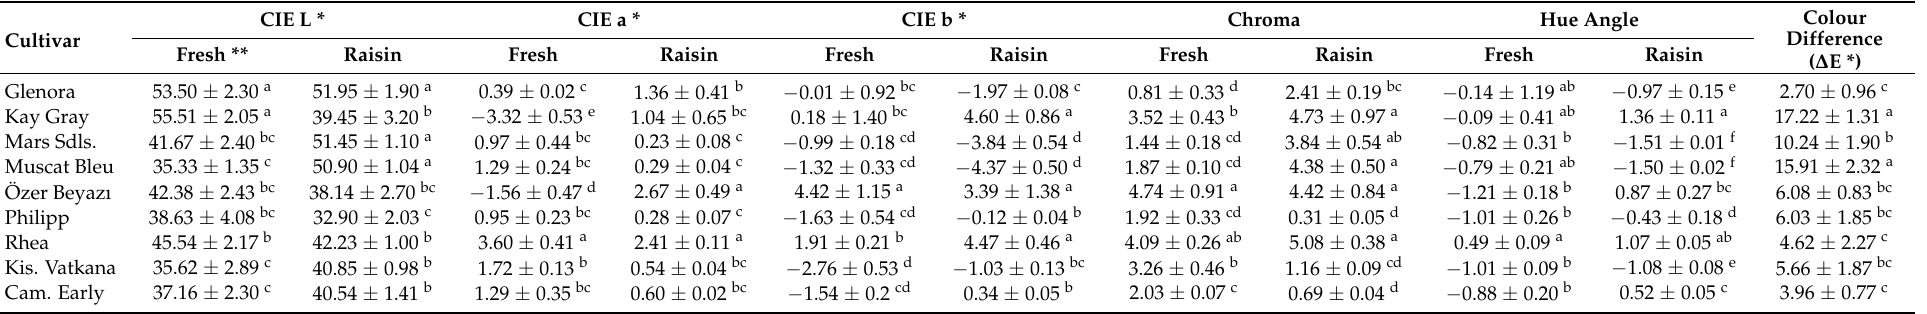
Table A4. Colour properties (CIELab) of fresh grapes and their raisins from different cultivars and colour difference values after